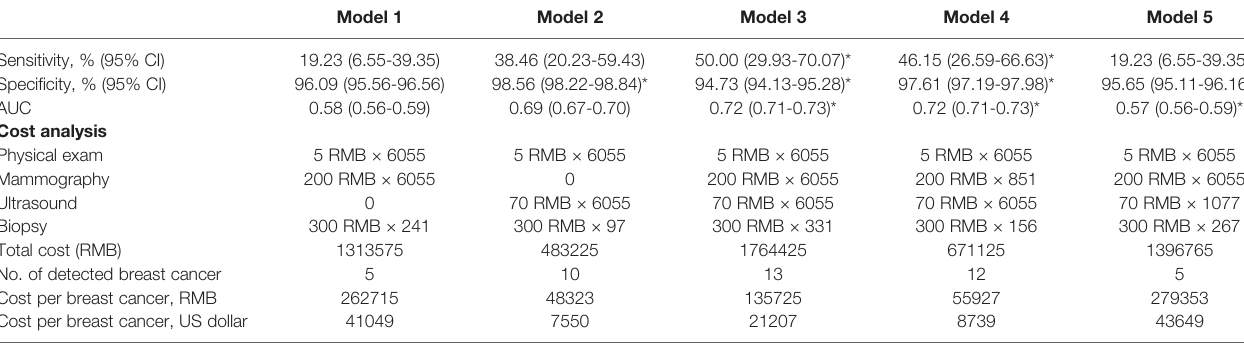
AUC, the area under the receiver operating characteristic curve; CI, con fi dence interval. Model 1: Mammography alone; Model 2: Ultrasound alone; Model 3: Ultrasound and Mammography co-testing; Model 4: Ultrasound BI-RADS 3 then Mammography; Model